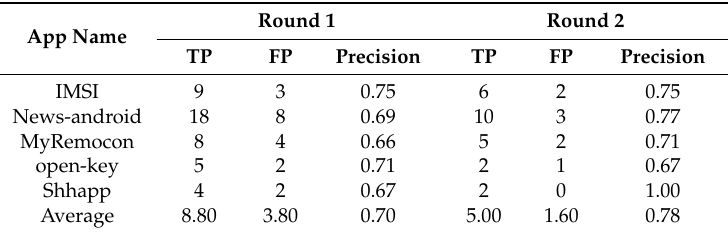
Table 1. Precision of symptom